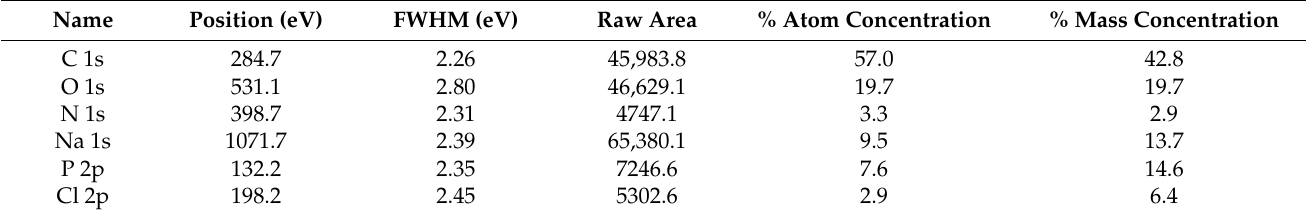
Table 2. The elemental composition of Purolite S 940 determined by the XPS method.